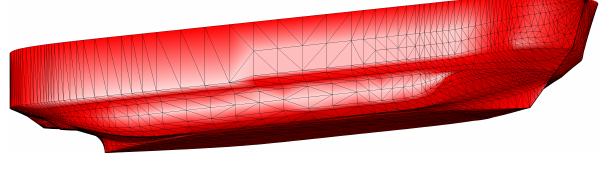
Figure 2: Fluid mesh of a conceptual Arctic drillship (courtesy Statoil).